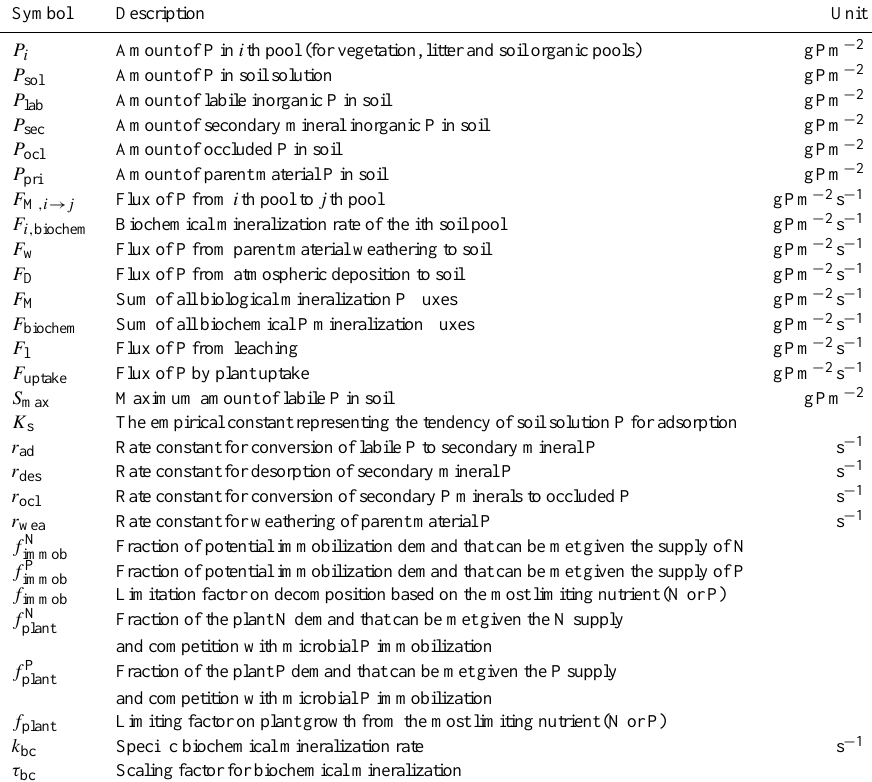
Table 1. List of variables and their definitions. Symbol